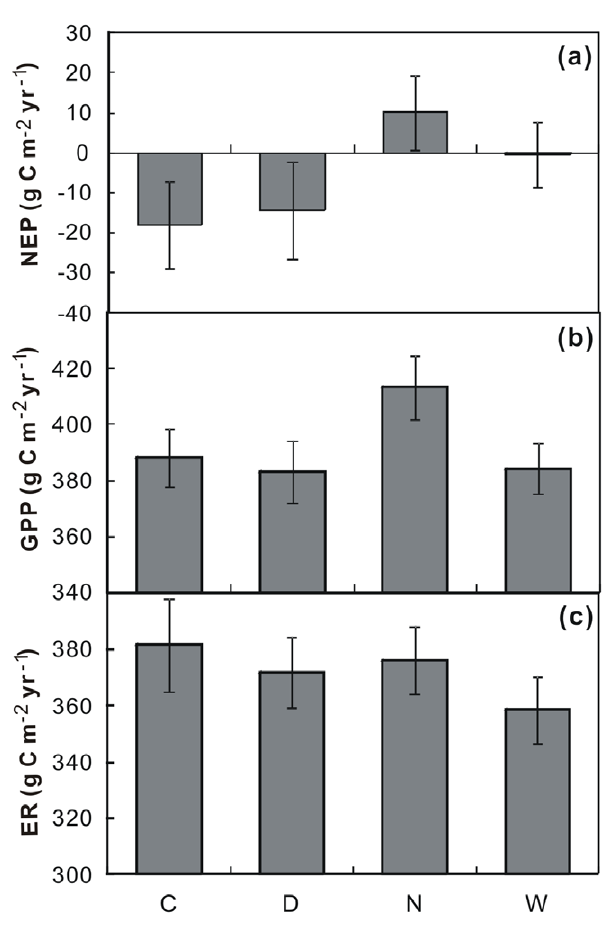
Figure 5. Mean values of net ecosystem productivity (a; NEP), gross primary productivity (b; GPP), and ecosystem respiration (c; ER) under control (C), day warming (D), night warming (N), and whole-day warming (W) from 2006 to 2009. Means 6 SE are shown. Both the x- and y-axis are in different scales among the 8